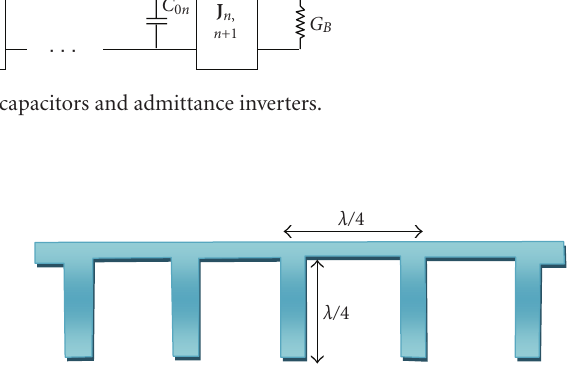
Figure 2: Conventional commensurate microstrip BSF derived from the LPF